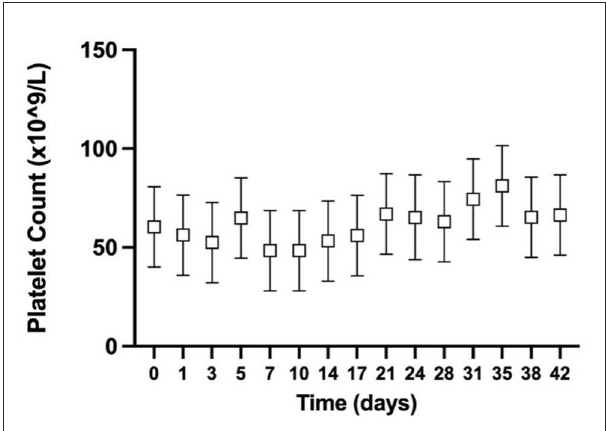
FIGURE1 Serial estimated marginal means with 95% confidence intervals of the estimated manual platelet count from greyhound whole blood cold-stored for 42